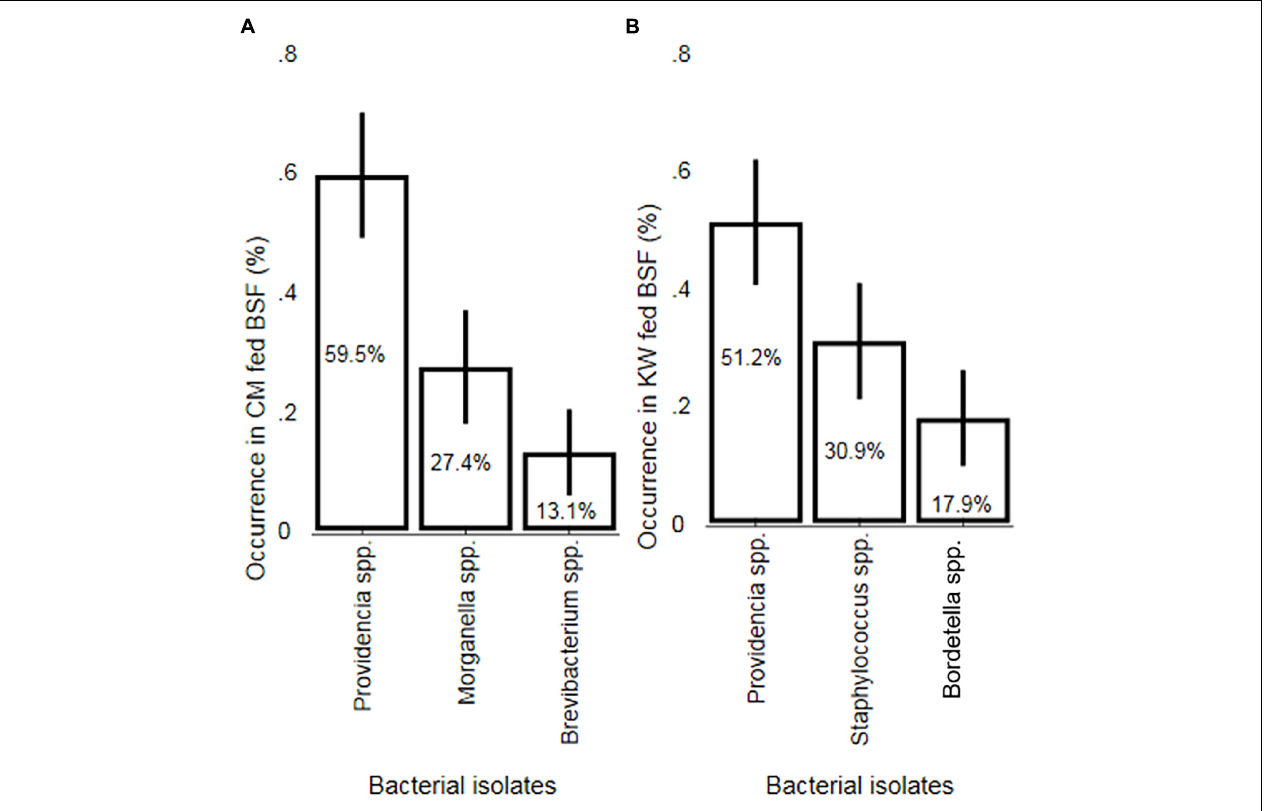
FIGURE 1 | A two-sample test of proportions (Z-test) for non-parametric data depicting the occurrence of bacterial isolates obtained from larvae guts of BSF previously reared on CM and KW substrates. Mean bacterial isolates occurrence (in%) in the gut of (A) chicken manure (CM) and (B) kitchen waste (KW) fed black soldier fly larvae (BSFL). Error bars represent 95% confidence intervals. TABLE 1 | Summary of the identified bacterial species using 27 F and 1492 R primers. Bacterial isolates